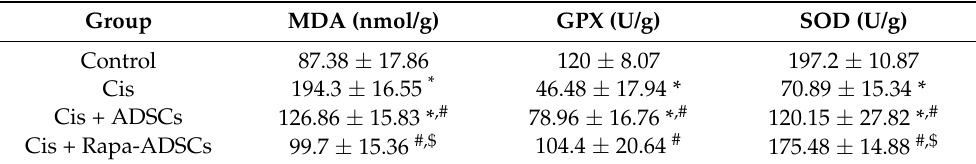
Table 3. The effect of rapamycin-preconditioned ADSCs on liver antioxidative potential; MDA, GPX and SOD, after cisplatin (Cis)-induced liver damage.